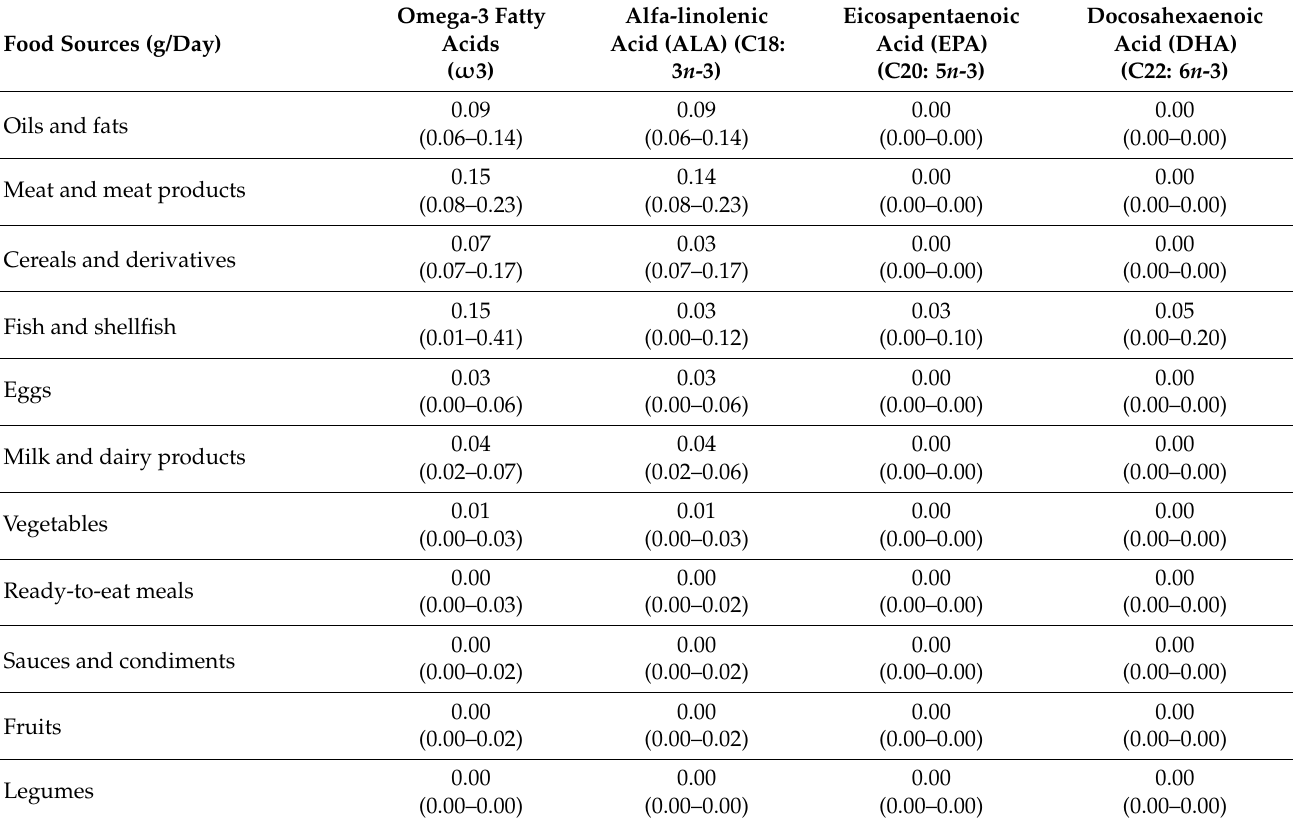
Table 12. Contribution of dietary food sources to omega-3 fatty acid intakes among the ANIBES Study